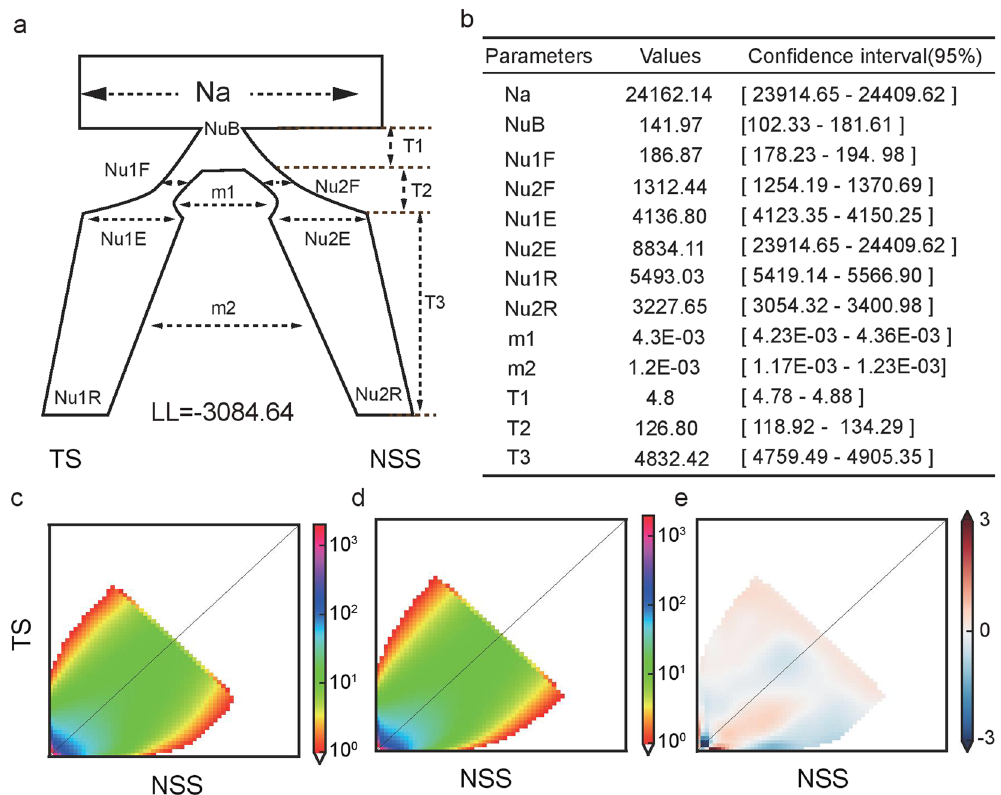
Figure 3. Population divergence estimated by ∂ a ∂ i. ( a ) The demographic model allows for two successive bottlenecks caused by domestication and founder effects of temperate population formation. The duration of the domestication bottle neck ( T1 ), population split and recovery time ( T2 ), and population divergence time ( T3 ) were estimated. The population size at each time point was also estimated. The migration rates are expressed as M ij, where M ij/2 Na = m ij, the proportion of individuals in population j who are new migrants ( M ) from population i every generation, and mij is the migration parameter estimated in ∂ a ∂ i. ( b ) Best-fit parameters inferred by ∂ a ∂ i simulations. The transformation to physical units is described in the Materials and Methods. ( c ) The joint allele frequency spectrum of the observed data. ( d ) The joint allele frequency spectrum built from simulated data according to the best model. ( e ) The Anscombe residuals between the simulated and observed